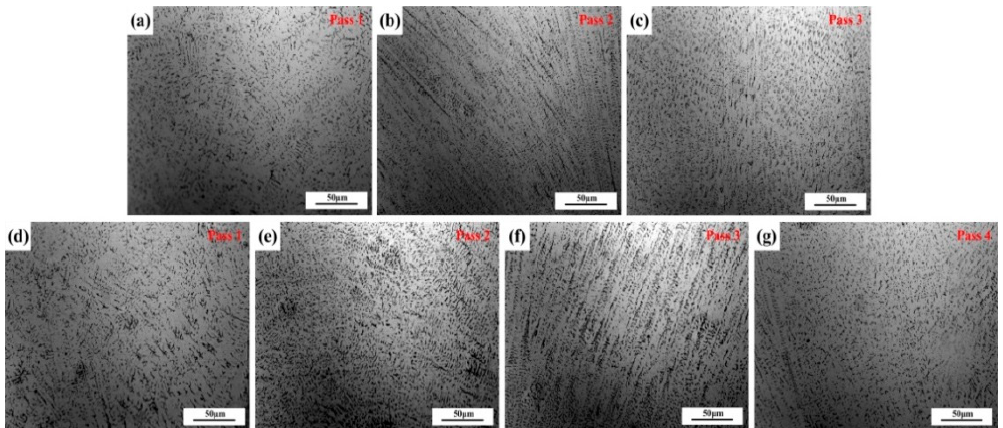
Figure 12. Weld seam microstructures of plates of different thicknesses at each pass, ( a – c ) for 1670-8 and ( d – g ) for 1670-14.